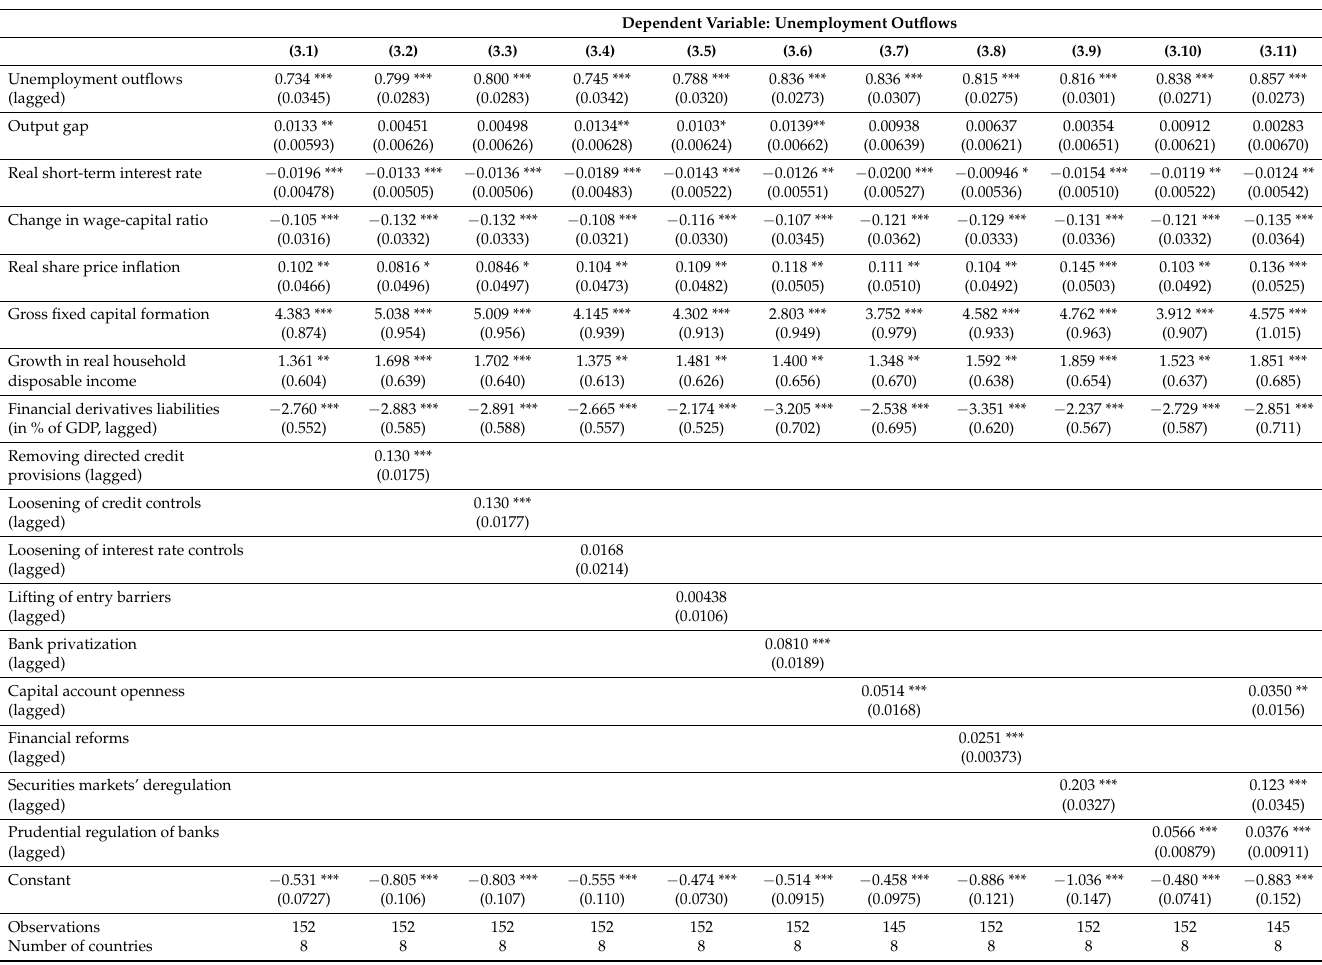
Table 3. Financial sector reforms and unemployment